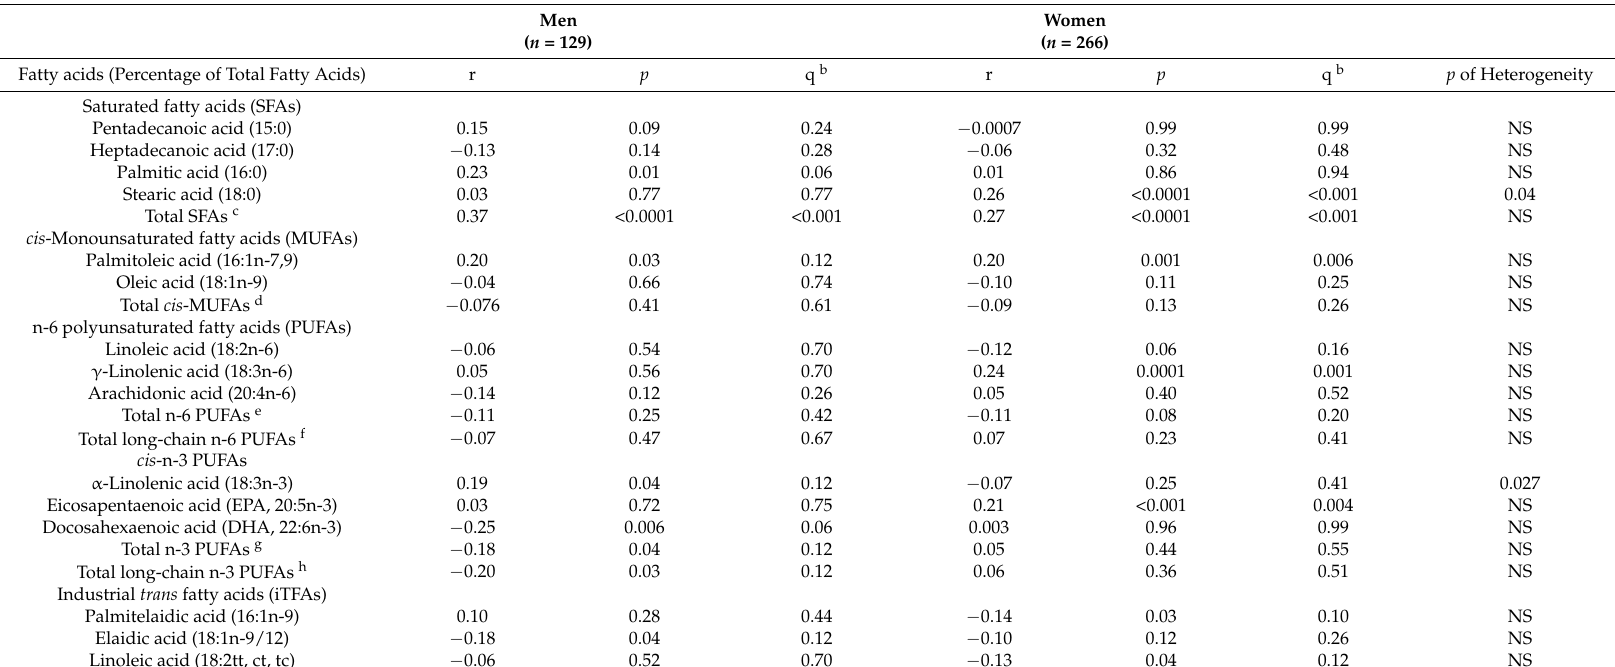
Table 4. Partial Spearman a correlations between serum phospholipid fatty acids and waist